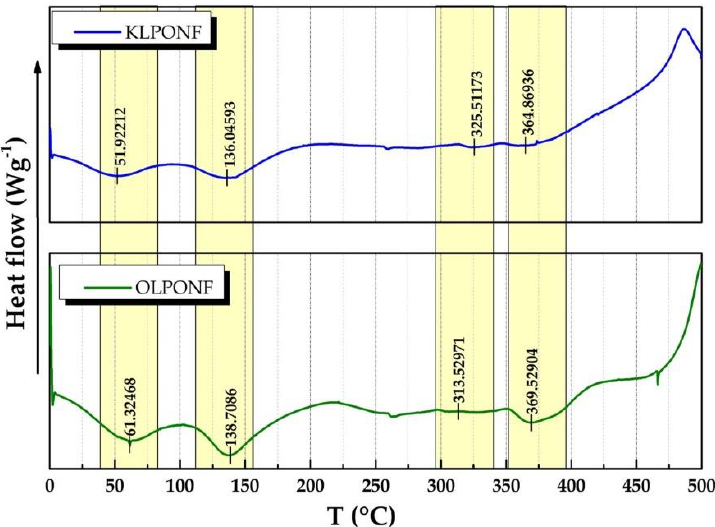
Figure 6. Differential scanning calorimetry (DSC) curves of lignin based composite membranes.